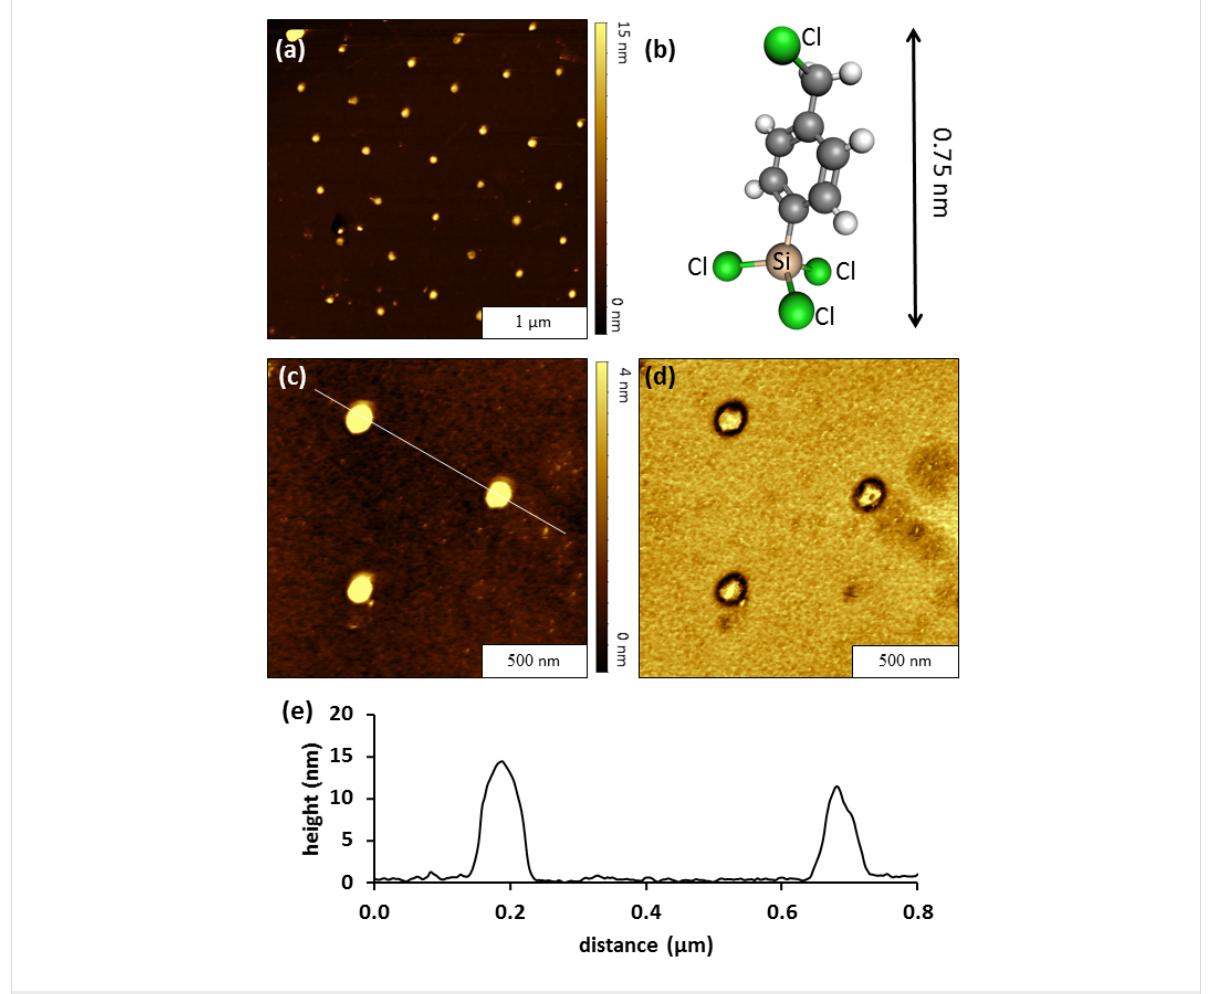
Figure 3: Nanodots of CMPS grown in a solution of BCH. (a) Topography image, 3 × 3 μ m 2 ; (b) structural model of CMPS. (c) High resolution (1.5 × 1.5 μ m 2 ) topography view of CMPS nanodots; (d) corresponding phase image. (e) Cursor profile for the line in (c).